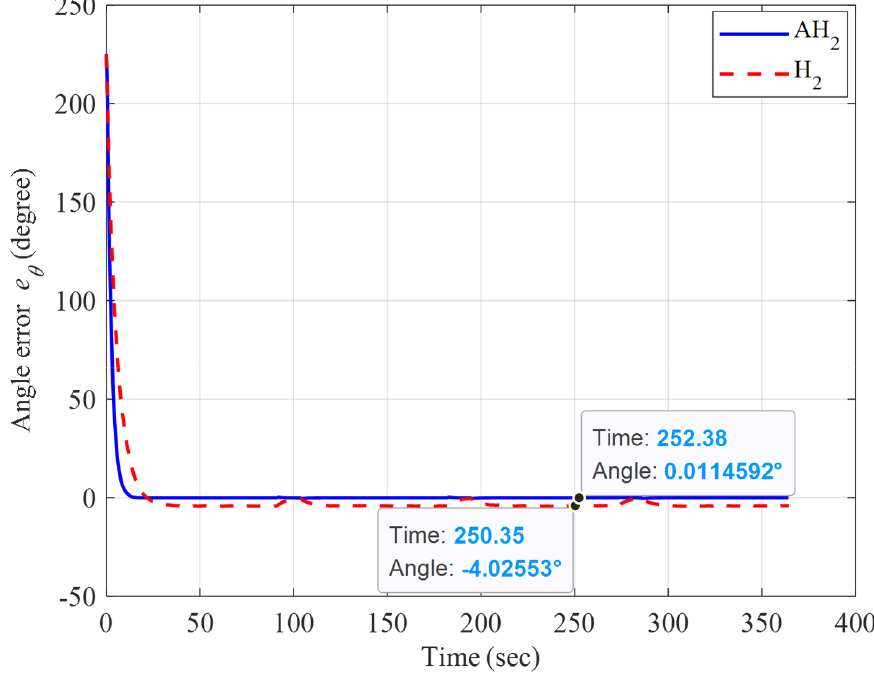
Figure 7. The square trajectory tracking result of the adaptive H 2 closed-form and H 2 closed-form control approaches for an angle from x p = 7 m, y p = 7 m.